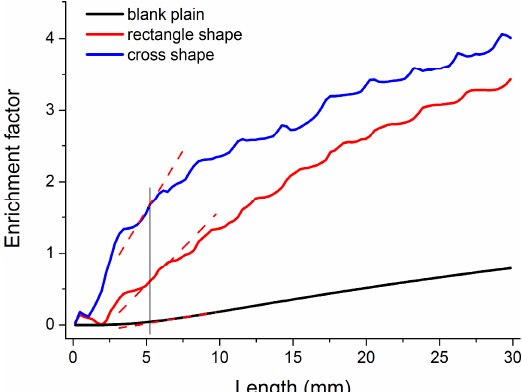
Figure 5. Simulation result of enrichment factor in the center of the organic extractant phase in the Figure 4. Velocity vector map (right) and corresponding streamline (left) of the plain blank microfluidic system for a single extraction cycle (dashed lines: the slope of fitted curves respectively). microchannel, the microchannel with microstructure of the rectangle shape, and the microchannel with microstructure of the cross shape (velocity vector: red arrows; streamline: black lines).